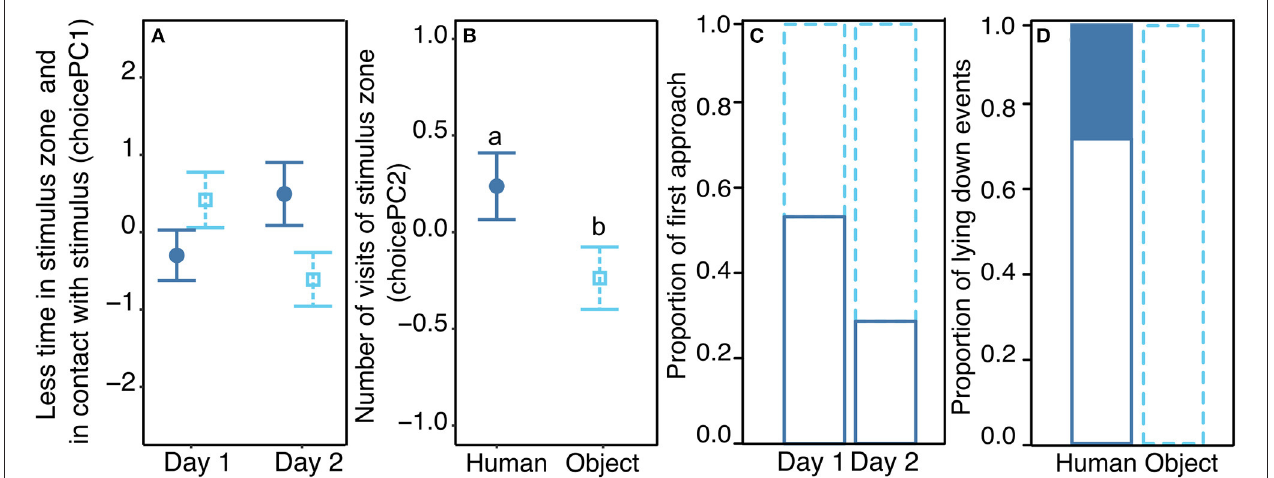
FIGURE 2 | Behavioral response in the Choice test. Mean ( ± se) of the two behavioral response scores from the PCA analysis, choicePC1 (A) and choicePC2 (B) , toward the two possible stimuli: either Human (filled dark blue circles) or Object (empty light blue squares). (A) Significant interaction between the stimulus and the day of the test but no differences revealed between groups in post hoc tests. (B) Significant effect of the stimulus on choicePC2. (C) first approach of the pig toward one of the stimuli either human (solid dark blue bars) or object (dotted light blue bars), indicated as proportion of the 24 pigs tested twice (day 1 and day 2). (D) Proportion of times that pigs laid down during the test either in the human zone or in the object zone. Different letters indicate significantly different groups ( p < 0.05). All model estimates, anova tables, and results of post ho c tests are available in Supplementary Tables 4–6 . Description of each behavioral parameter depending on experimental conditions is available in Supplementary Table 1